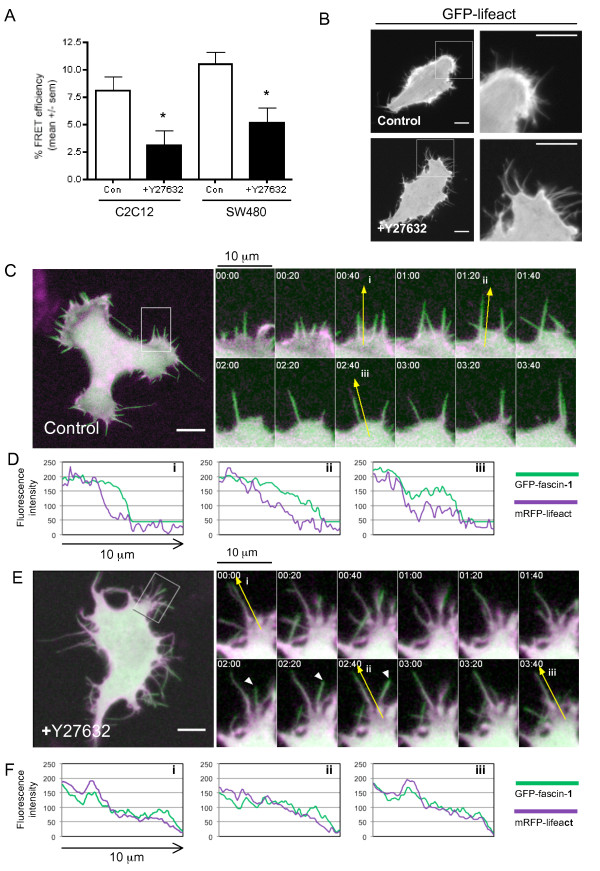
Rho kinase activity promotes the interaction of fascin-1 with actin. (A) Percentage FRET efficiency of the interaction of monomeric red fluorescent protein (mRFP)-fascin-1S39A with green fluorescent protein (GFP)-lifeact in SW480 cells on laminin (LN) under control conditions or after inhibition of Rho kinases by Y27632. Each column represents the mean from eight to twelve cells per condition and three independent experiments; bars indicate SEM. *P < 0.05 versus control. (B) Confocal images of the same non-fixed SW480 cell transiently expressing GFP-lifeact, before and after treatment with Y27632 (see Additional file 4, movie 1). The boxed 25 × 25 μm regions in the lefthand panels are enlarged in the zoomed right panels. Scale bars, 10 μm. (C,E) Fascin-1 and F-actin dynamics in SW480 cells transiently expressing GFP-fascin-1 and mRFP-lifeact, (C) without or (E) with Y27632 treatment (see Additional files 5 and 6, movies 2 and 3). (C,E) Left panels show representative cells from four independent confocal time-lapse movies. Scale bars, 10 μm. Right panels show zoomed images from the boxed 10 × 15 μm regions in the lefthand panels. (D,F) Fluorescence line-scan analysis of GFP-fascin-1 and mRFP-lifeact in a single filopodium from (D) control, or (E) Y27632-treated cells at three timepoints (i to iii). (C,E) Yellow arrows indicate the filopodia analyzed; (E) arrowheads indicate another example of an unstable filopodium. Scale bars, 10 μm.